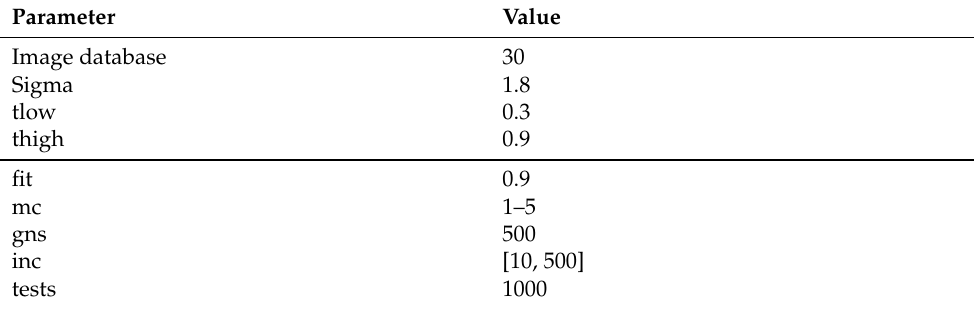
Table 4. CDS input parameter values for evaluation and validation